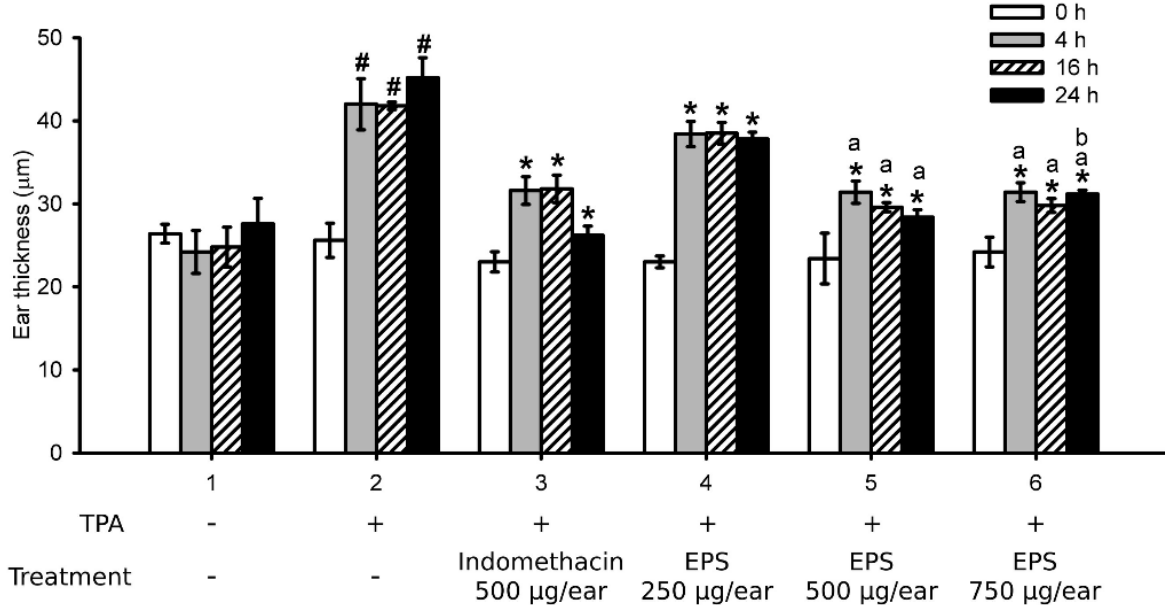
Figure 3. EPS ameliorated 12- O -tetradecanoylphorbol-13-acetate (TPA)-induced ear edema in an- imal models. Mice were treated with TPA (Groups 2–6) or vehicle (Group 1) on their right ears. One hour later, vehicle (Groups 1 and 2), 500 μ g/ear indomethacin (Group 3), or 250, 500, or 750 μ g/ear EPS (Groups 4, 5, and 6, respectively) was applied on the ear. Ear thickness was measured before (0 h) and at 4, 16, and 24 h after TPA treatment. Data are presented as the mean ± standard deviation of each group (N = 5). # p < 0.005 vs. 0 h of Group 2; * p < 0.005 vs. the same time point of Group 2; a p